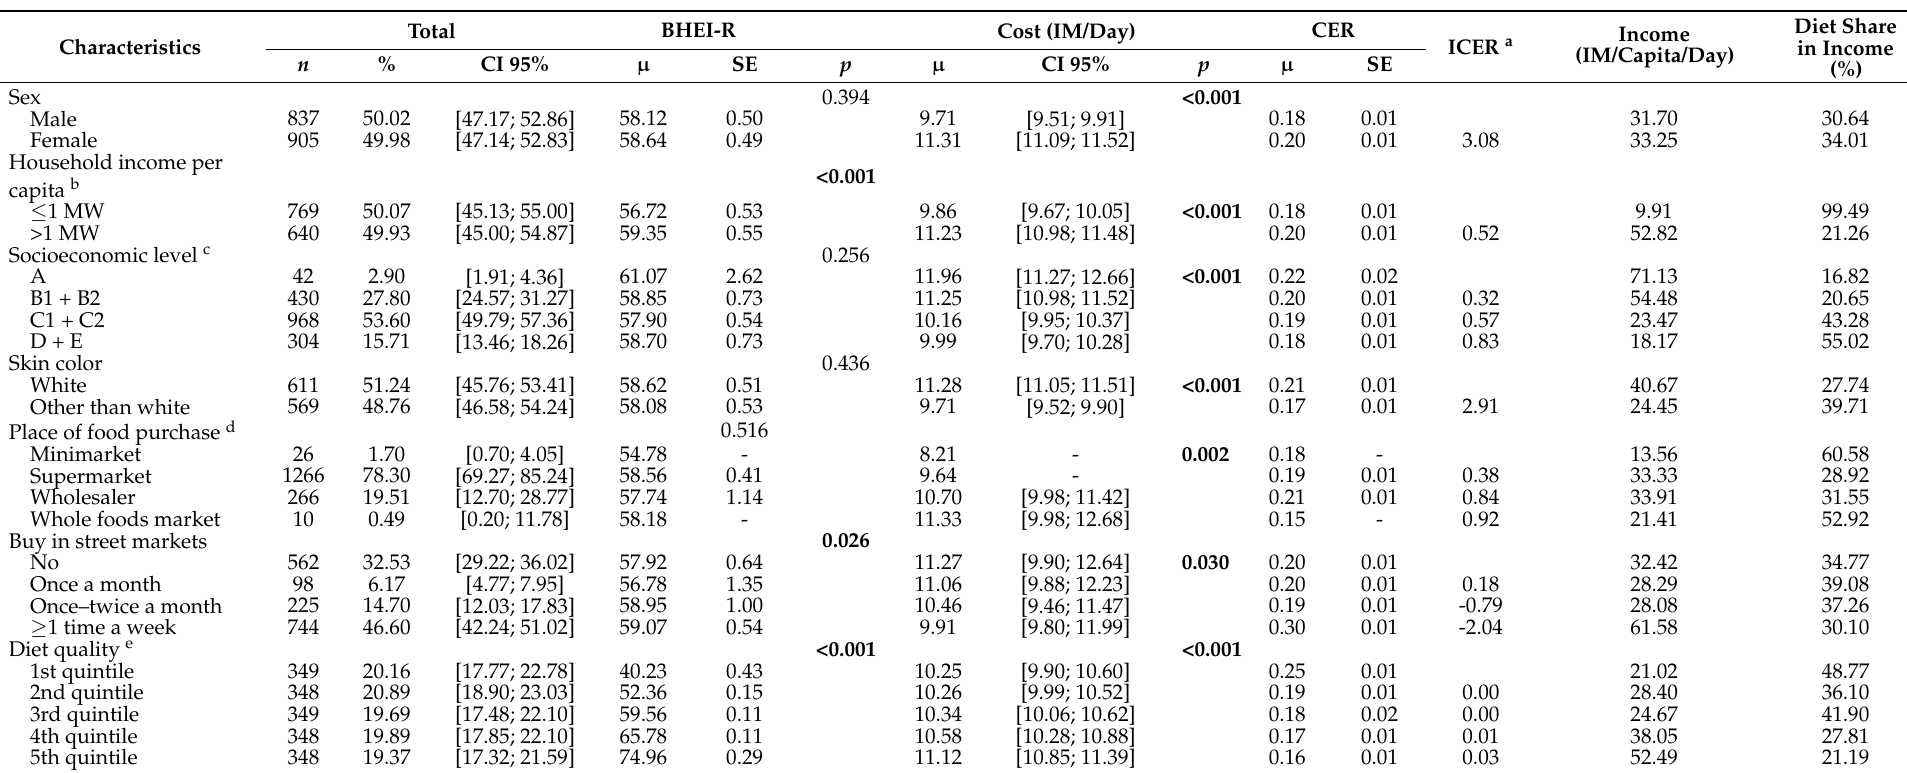
Table 1. Diet quality, cost, and cost-effectiveness ratio, according to individuals and household socioeconomic, demographic variables, and food purchase profile. ISA-2015, Sao Paulo,